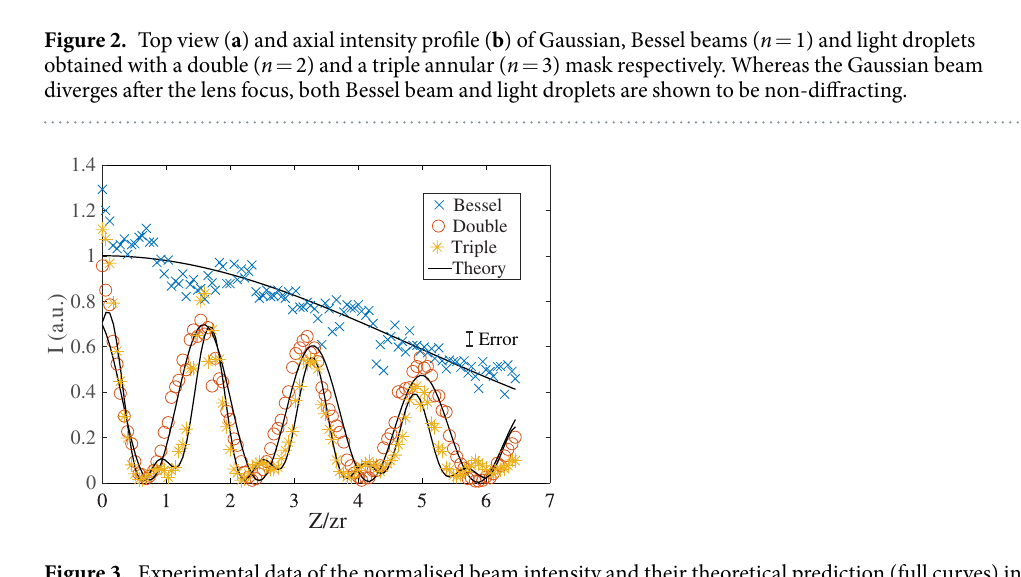
Figure 2 reports the beam intensity profiles along the ˆ z axis for a Gaussian beam and different light-droplet 02 , with w realizations. Distances are normalised to the Rayleigh length π λ = z w n / 0 being the minimum beam R waist of the Gaussian beam at the focal plane. In Fig. 1a the beams were obtained using a Gaussian mask, a single annulus ( n = 1), two annuli ( n = 2), and three concentric annuli ( n = 3). Unlike the diffracting Gaussian beam, which diverges after the focal plane of the Fourier lens, the Bessel beam propagates along the optical axis with a constant width of the central peak. Diffraction-free light droplets arise from the interferometric beating of co-propagating Bessel beams for n > 1. Figure 2b reports the x - y integrated intensity distribution of the beams along the ˆ z axis. Light droplets in the n = 3 case show a more localized profile in ˆ z compared to the n = 2 case, as expected from the three wave interference. For a fixed sample thickness and experimental scenario, a sufficiently high value of n will, in principle, give rise to a single diffraction-free light droplet. Figure 3 illustrates the normalised peak intensity of a Gauss-Bessel beam and light droplets ( n = 2, 3) meas- ured along the ˆ z direction. The data shows good agreement with the theoretical predictions described in the Methods. In Fig. 4a,b we demonstrate the use of light droplets to excite and detect fluorescent molecules typical of most imaging schemes. We measured the fluorescent emission given by the Rhod-2 fluorescent dye labelling a thin glass layer. In Fig. 4a we report the resulting fluorescent signal given by both Bessel beam and light droplet illumina- tions along the optical axis. The labeled glass layer was first imaged at the CCD plane and then translated along the ˆ z direction together with both objective lens and CCD camera to maintain a constant magnification during the scan. A long pass filter was placed at the detector plane to reject all the incident light transmitted by the glass and to detect only the fluorescent signal emitted, which had a central wavelength at approximately 581 nm. In Fig. 4c,d we demonstrate light droplets in strongly scattering liquid volumes. We report the intensity distri- bution of light droplets compared to simple Bessel beams in water-milk solution at concentrations that simulate real biological tissues (water-milk scattering is similar to that of intralipid solutions in the range of 1% and 10%) 21 . All beam profiles were taken along the propagation in a glass cuvette of 10 mm length filled with the scattering liquid. Despite a decreasing signal strength and contrast, both Bessel beams and light droplets maintain equal profile and propagation path as the milk concentration increases.